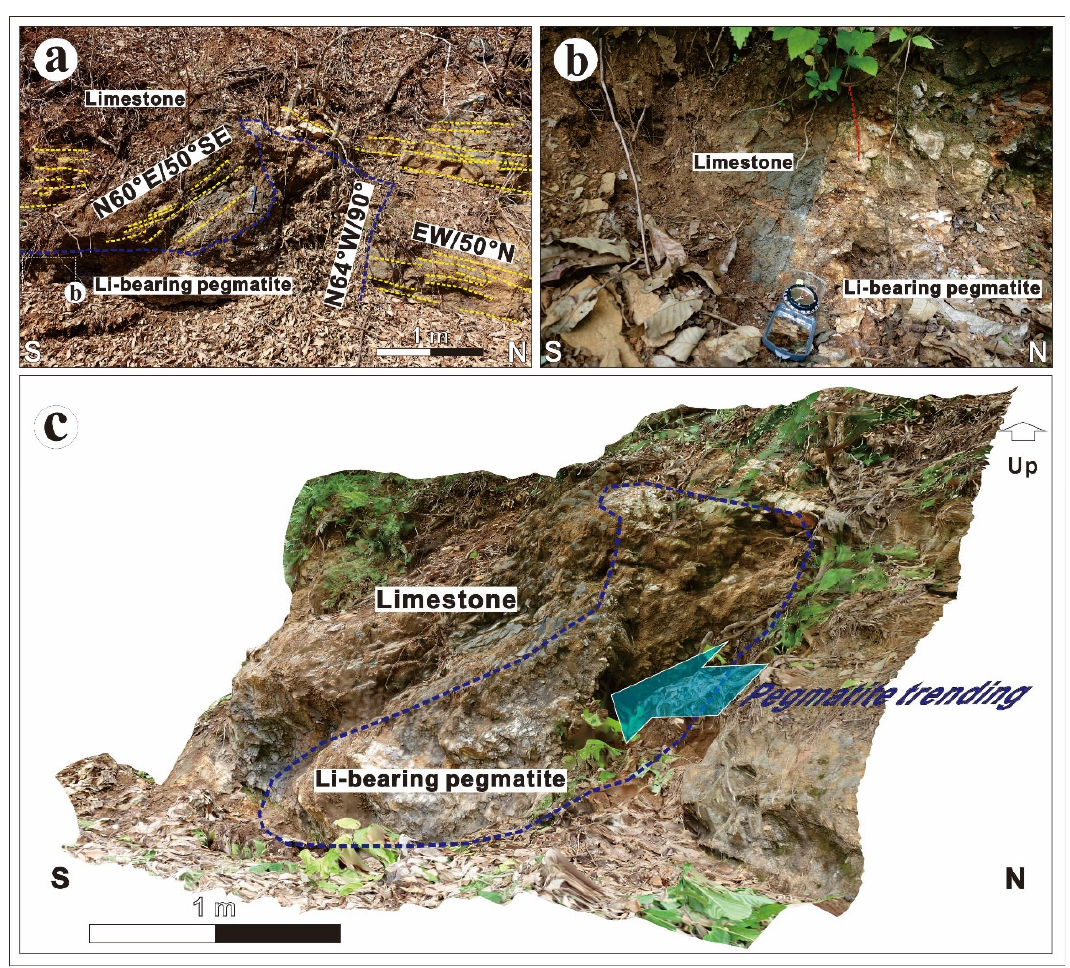
Figure 10. Rare ‐ element pegmatite (REP) body Pgt 8 developed in the outcrop. ( a ) The bedding changes from an EW/50° N strike to a N60° E/50° SE strike where the REP body is exposed. The N64° W/90° ‐ striking fracture is bound to the northern part of the body. ( b ) The limestone layer overlies the pegmatite. ( c ) The direction of the pegmatite intrusion is parallel to the bedding of the overlying limestone.